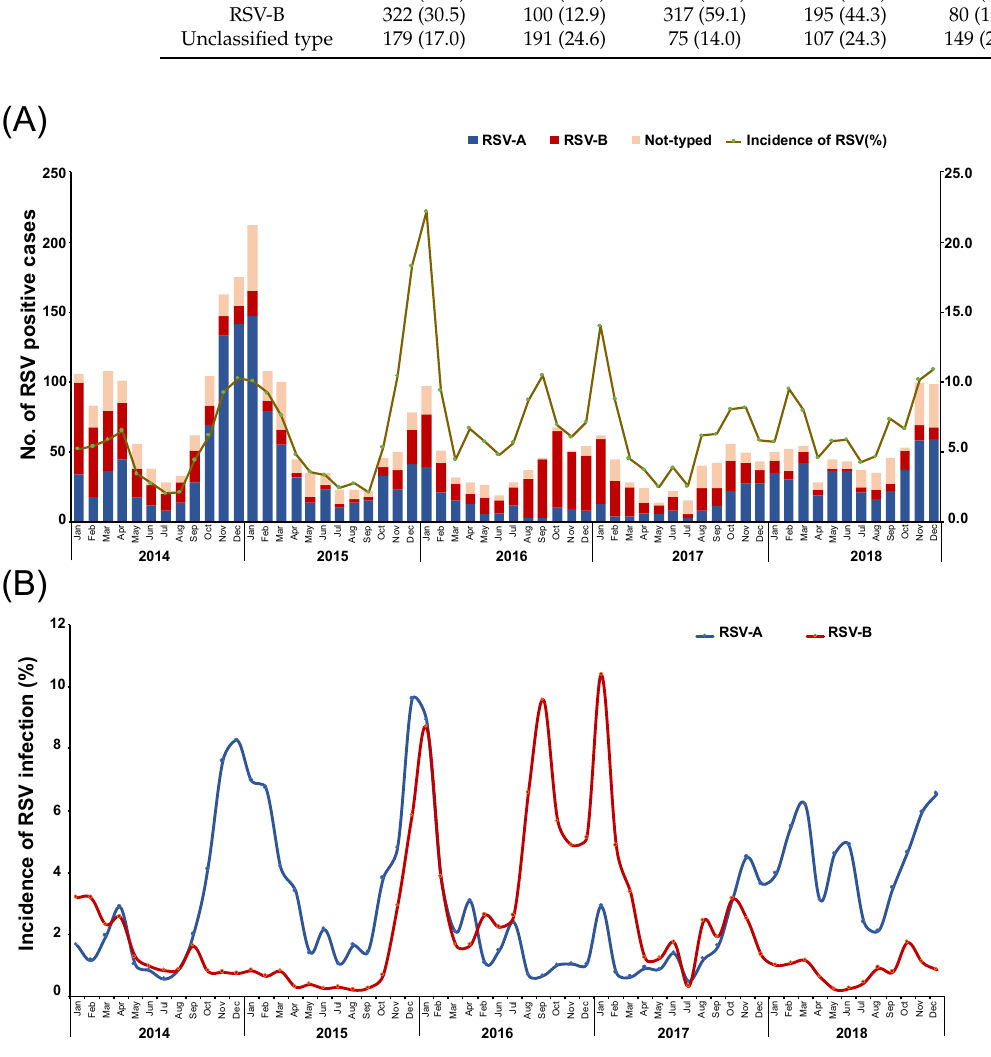
Figure 1. Monthly distribution of RSV-A and RSV-B from January 2014 to December 2018 in China. The number of RSV-A- or RSV-B-positive patients and the monthly RSV incidence (% of RSV-positive patients in the indicated month) are shown. ( A ) The numbers of RSV-A-positive and RSV-B-positive cases; ( B ) the monthly incidences of RSV-A and RSV-B.